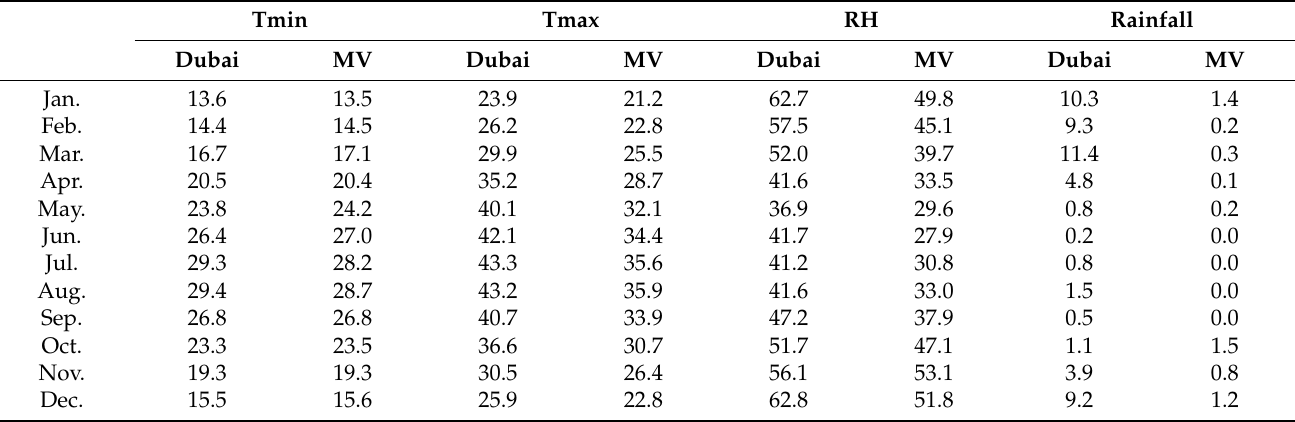
Table 2. Monthly average of daily temperature (Tmin and Tmax), relative humidity (RH) and rainfall in Dubai and Mubarak Valley (MV) over the period 2000 and 2020. Data source: ERA5. Tmin Tmax RH